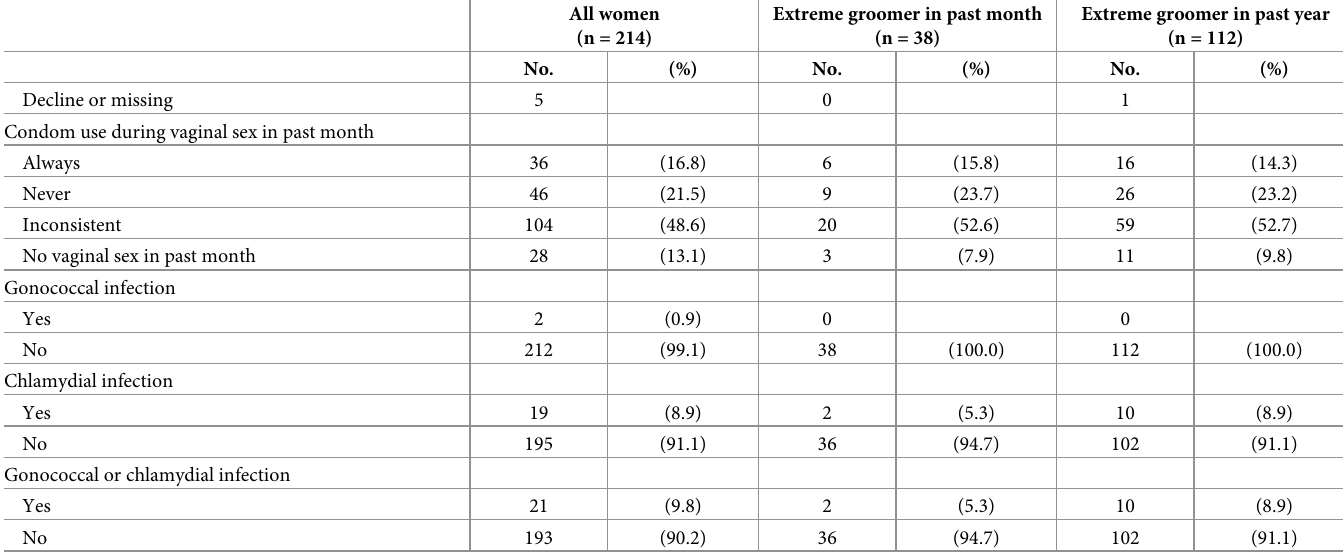
or weekly pubic hair trimming). Overall, 7% of respondents reported a history of secretory STI